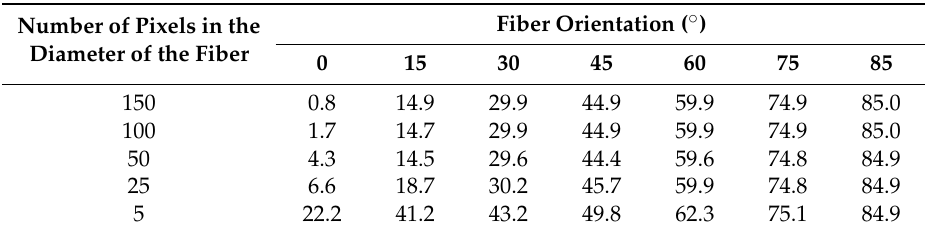
Figure 3. Error of the measured orientation of an artificial fiber image according to the number of pixels in the diameter.